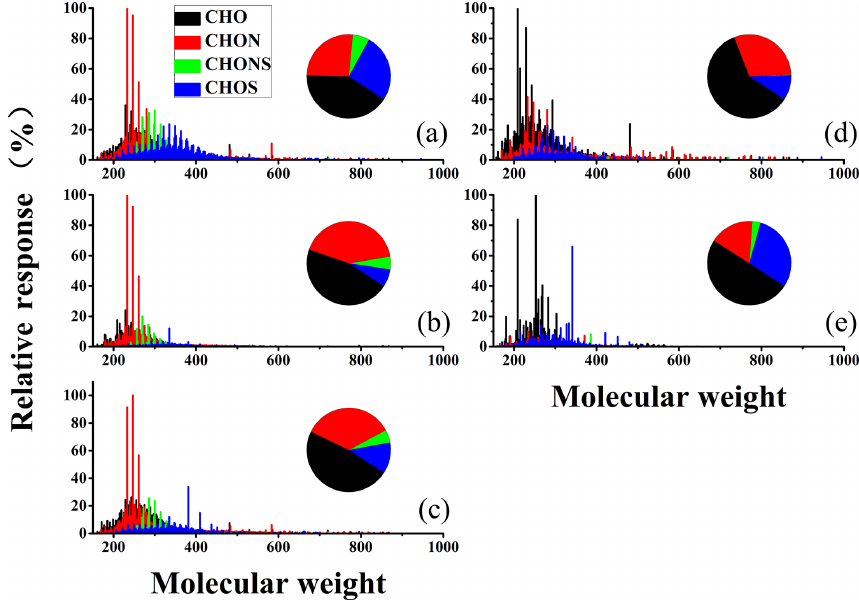
Figure 1. Mass spectra of POCs in water extractions for off-road diesel engine emissions. Panels (a) , (b) , (c) , (d) , and (e) were the mass spectra for excavators in idling, working, and moving modes and vessels using diesel and HFO, respectively.